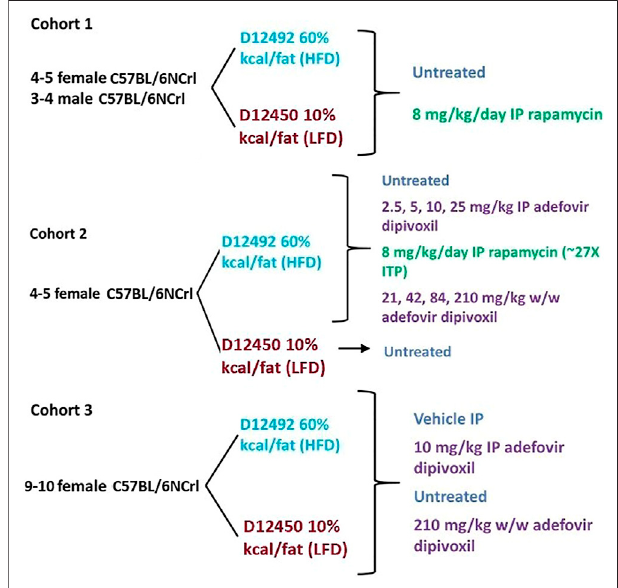
FIGURE 1 | Experimental Layout . Experimental layout of the three cohortsofmiceexaminedinthisstudy.Allanimalswere8 – 9 monthsoldatthe time they were started on a diet/treatment